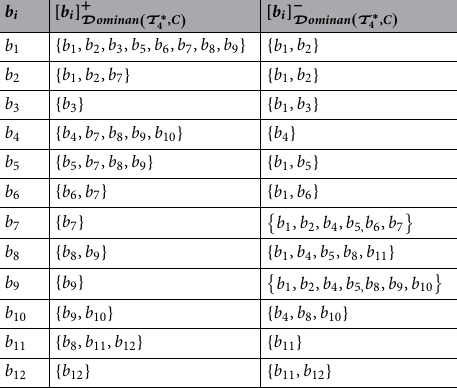
Table 5. Dominating classes [ b i ] + D ominan ( T ∗